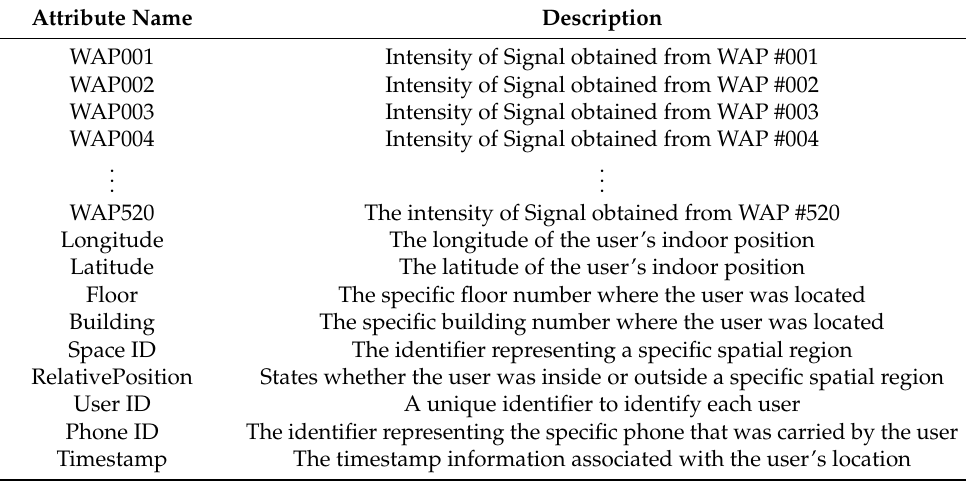
Table 2. Outline of the attributes in the data that were used to develop, implement, and evaluate the proposed